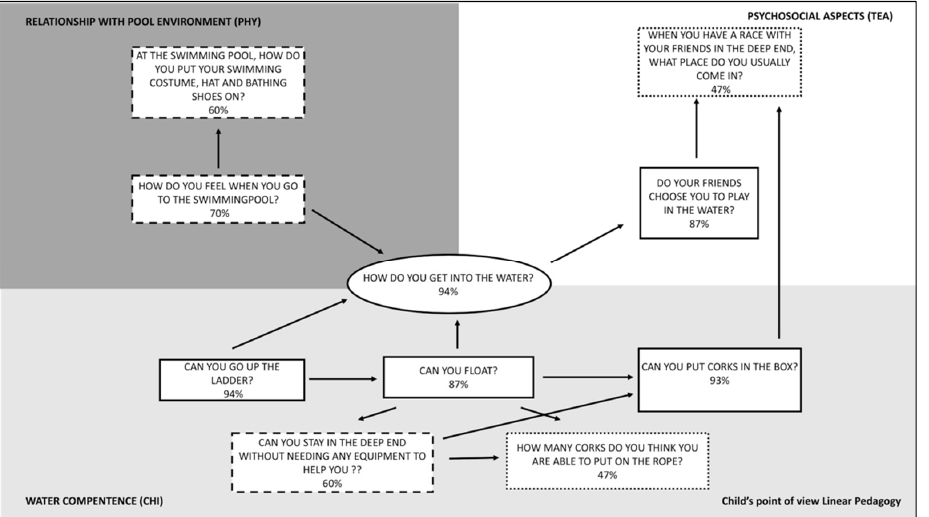
Figure 4. Diagram related to the perception of the children of the LI group according to the results of the pictorial scale indicating the percentage of positive responses.